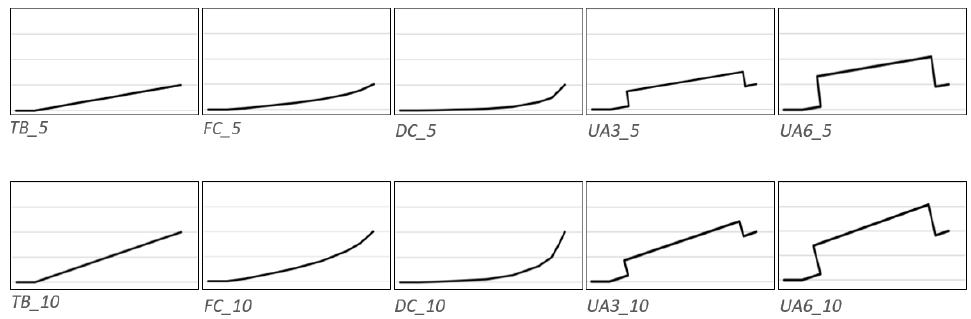
Figure 2. Template of the cantilever configurations in the sagittal view.